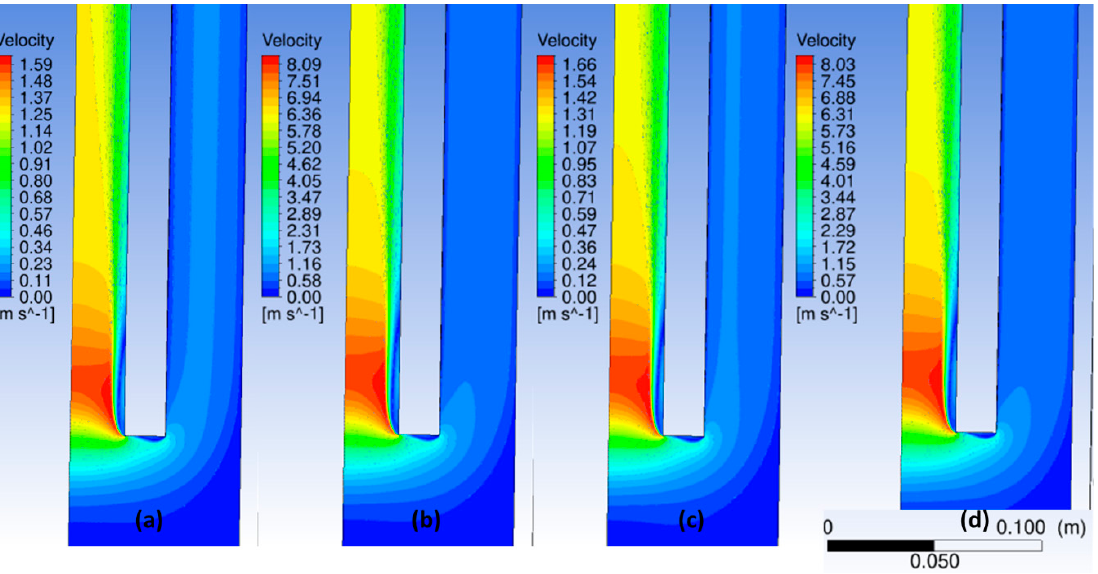
Figure 8. Velocity distribution at the bottom of the internal tubing for a mass flow rate injection with constant water properties of 2 kg/s ( a ) and 10 kg/s ( b ) and with the IAPWS-IF97 properties for 2 kg/s ( c ) and 10 kg/s ( d ).